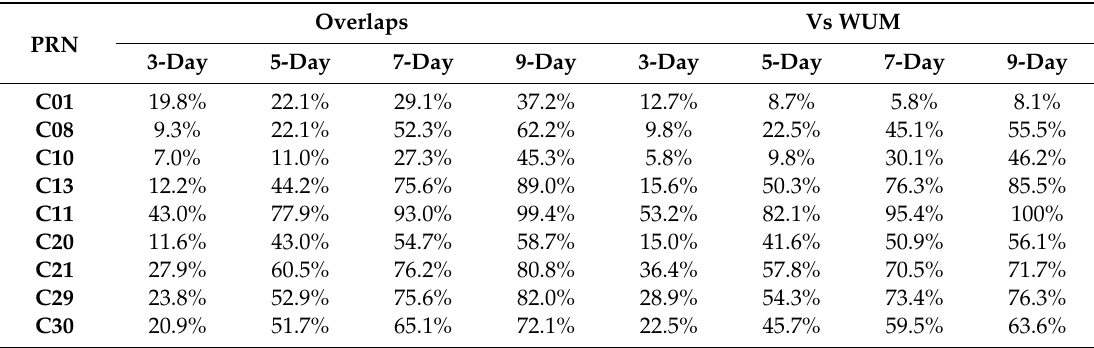
Table 4. The success rate of multi-day